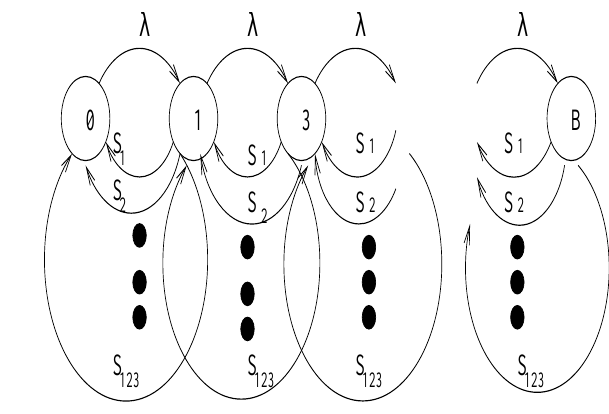
Figure 6. Automaton for request arrival done by the synchronization S (cid:21) . The